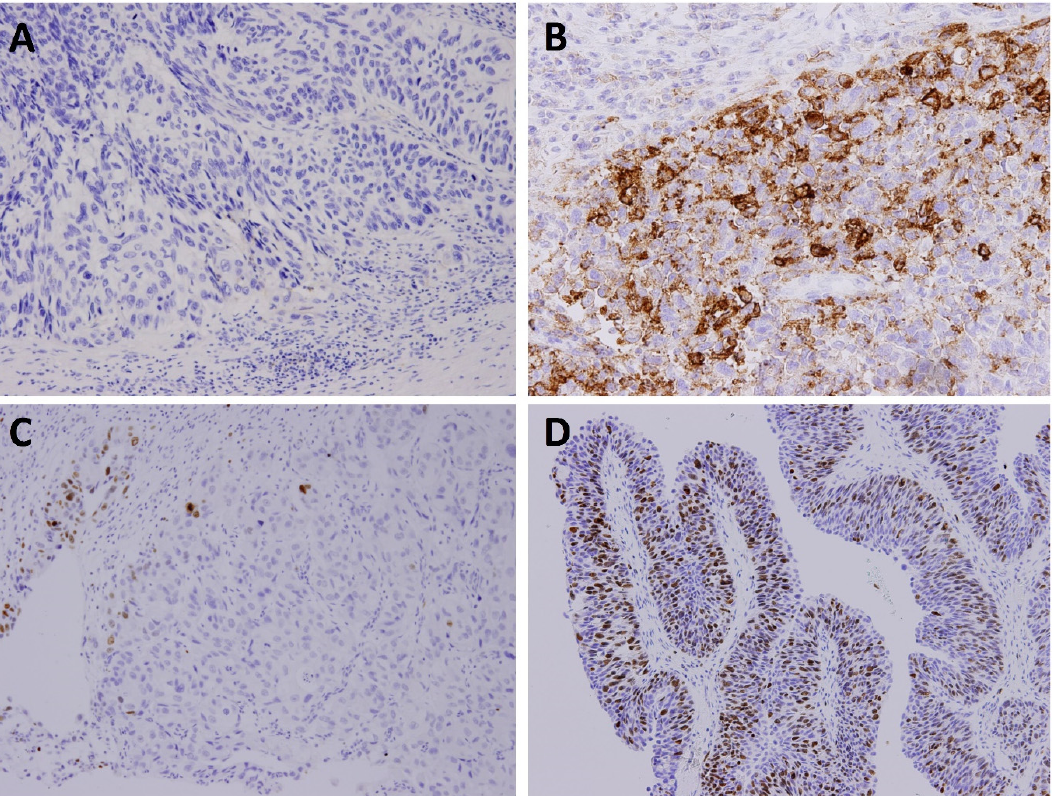
Figure 1. Representative photomicrographs showing PD-L1 expression through immunostaining (200 × ): ( A ) Negative PD-L1 expression (CPS < 10) and ( B ) PD-L1 expression (CPS = 50). Representative photomicrographs showing Ki-67 expression: ( C ) 5% and ( D ) 70%.